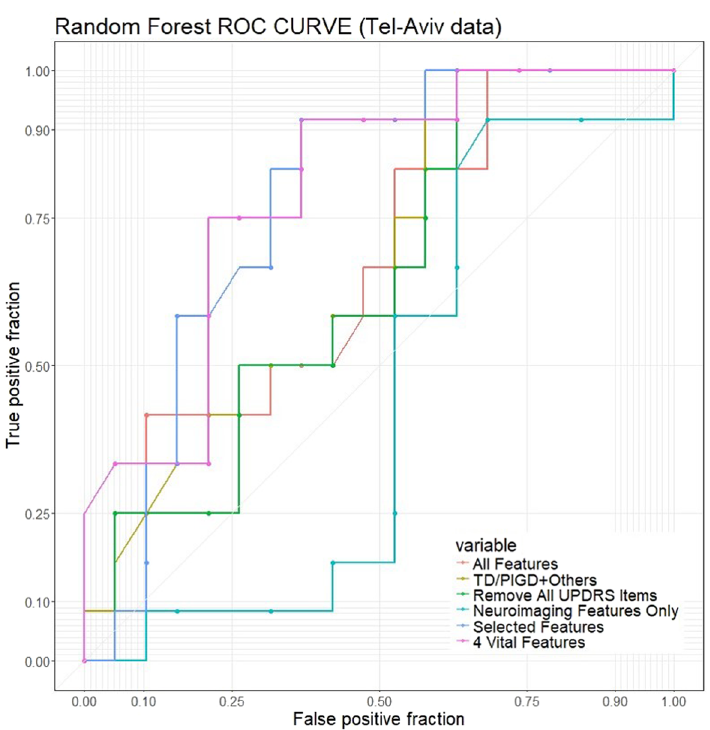
Figure 14. ROC plot for random Forest, lines in different colors represents the results under 6 different training conditions: (1) All features; (2) TD/PIGD classification and other clinical/demographic information; (3) Remove all UPDRS items; (4) Neuroimaging features only; (5) 10 selected features and (6) 4 vital features (PIGD Score, H_ and_Y_Off, FOG_Q, gaitSpeed_Off). Corresponding Area Under the ROC Curve (AUC) are listed in Table